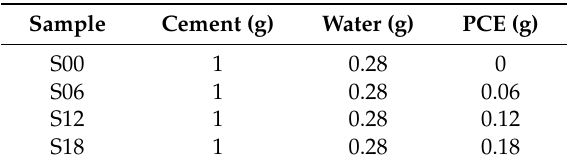
Table 2. Mix proportion of cement pastes with PCE (wt %).